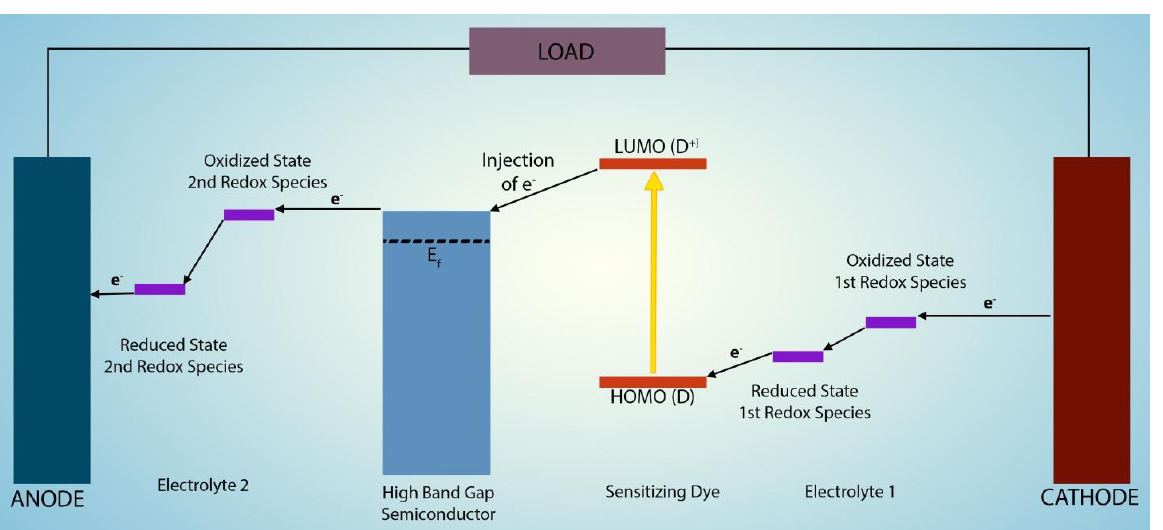
Figure 14. Band Gap schematic for a theoretical DSSC solar battery. The arrows show the flow of electrons through the solar battery